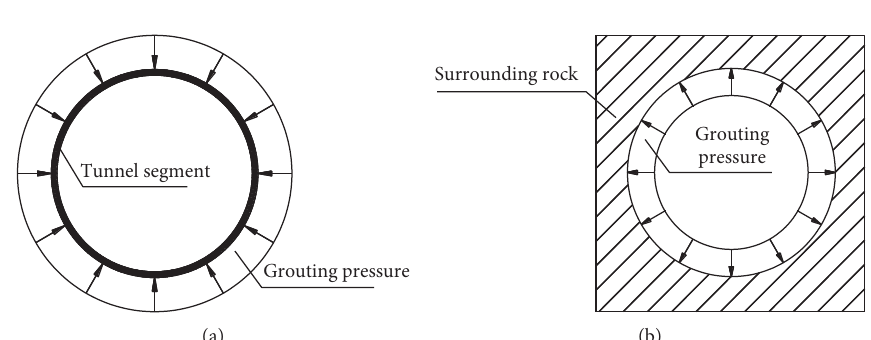
Figure 7: Sketch of synchronous grouting. (a) Segment grouting pressure diagram. (b) Schematic diagram of grouting pressure around the